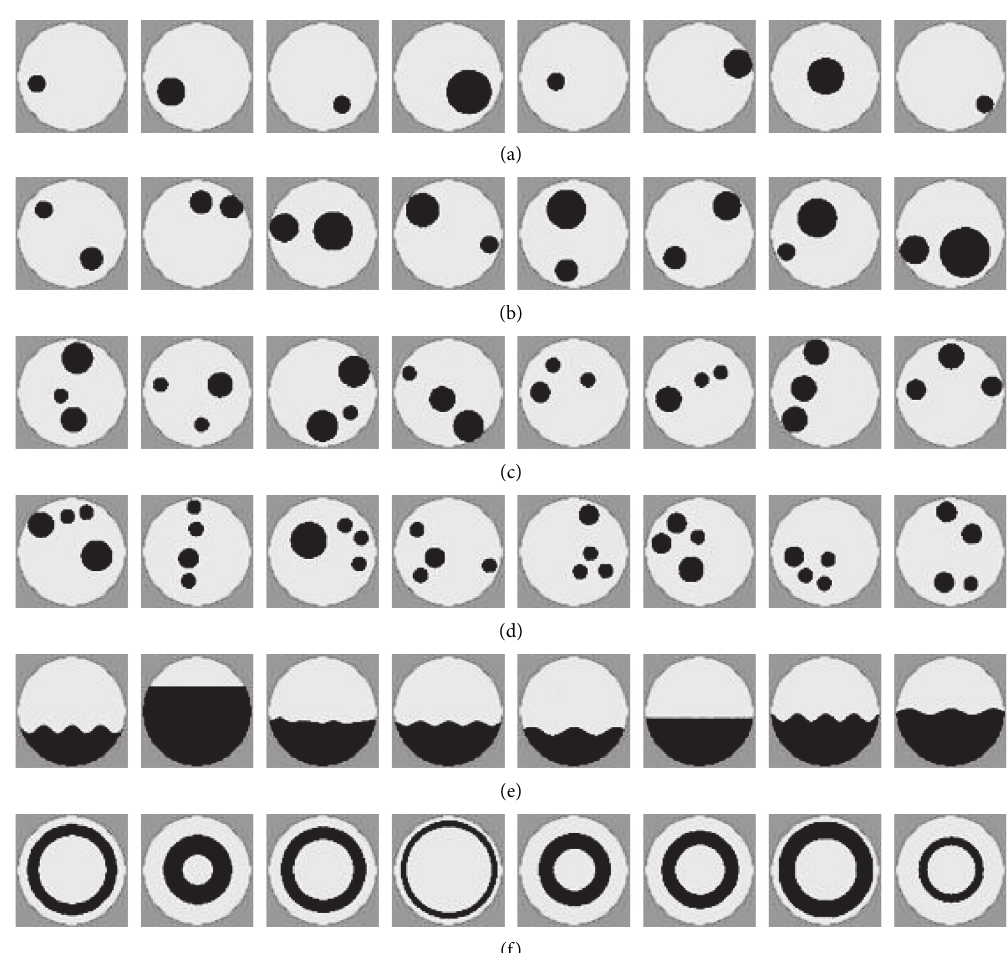
Figure 3: Presentation of partial sample sets. (a) Single bubble. (b) Two bubbles. (c) Three bubbles. (d) Four bubbles. (e) Stratified. (f)